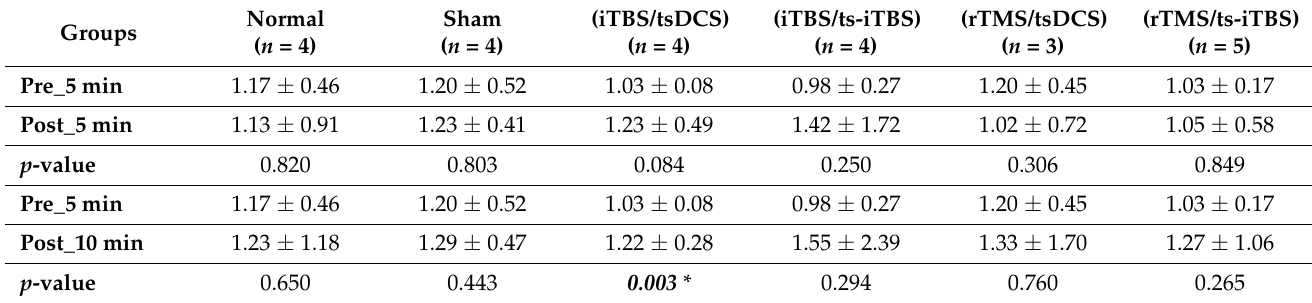
Table 2. MEP of both sides before vs. after surgery and stimulation intervention at different time points ( n =